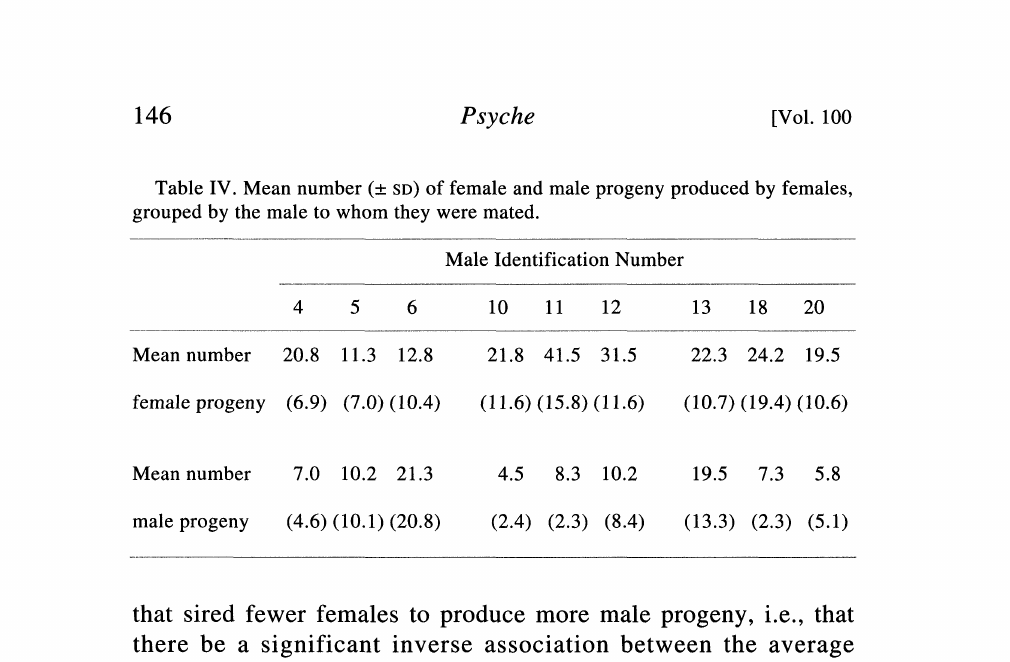
Table IV. Mean number (_+ SD) of female and male progeny produced by females, grouped by the male to whom they were